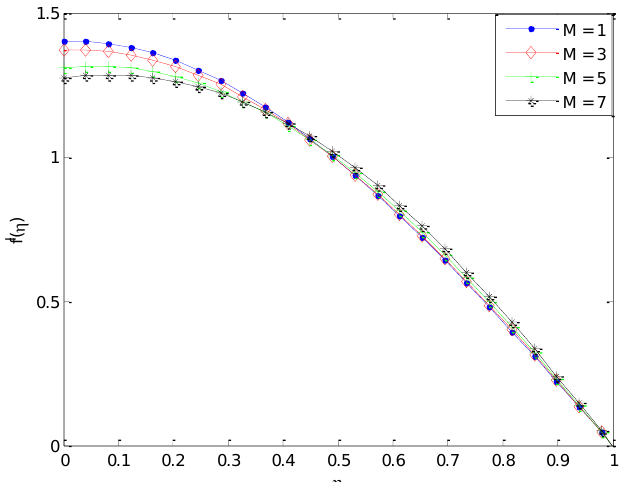
Fig. 3. Effects of magnetic number on the flow velocity of the fluid.